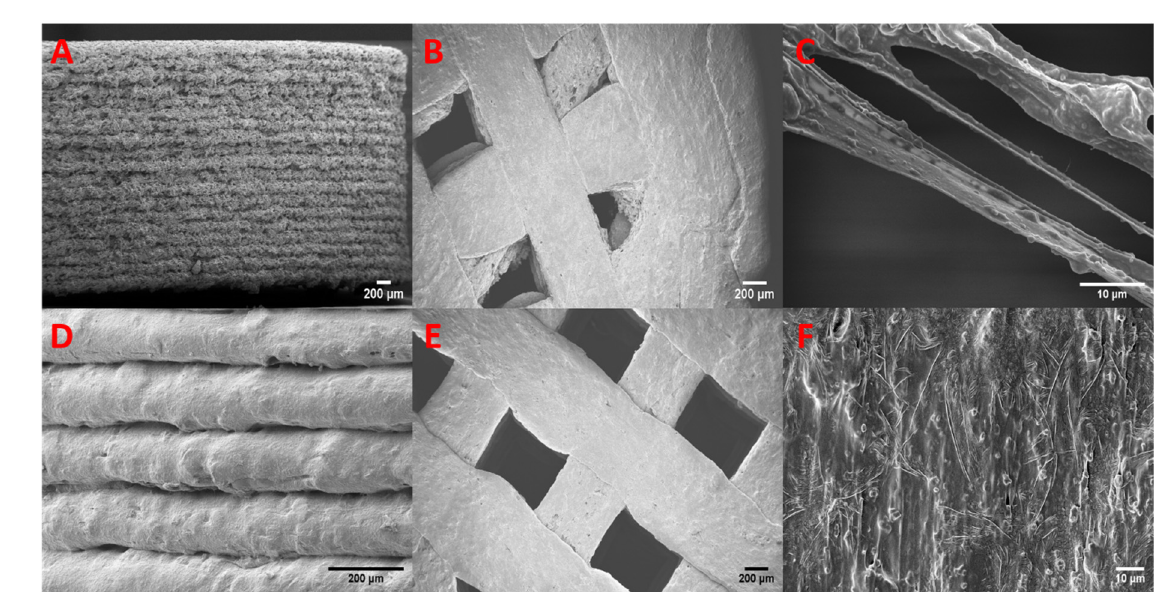
Figure 8. SEM images of mesoporous material containing filaments: ( A ) cross-section and ( B ) side view of MMC-contain- ing filament; ( C ) cross-section and ( D ) side view of MCM-41-containing filament. The arrows indicate polymer inclusions.